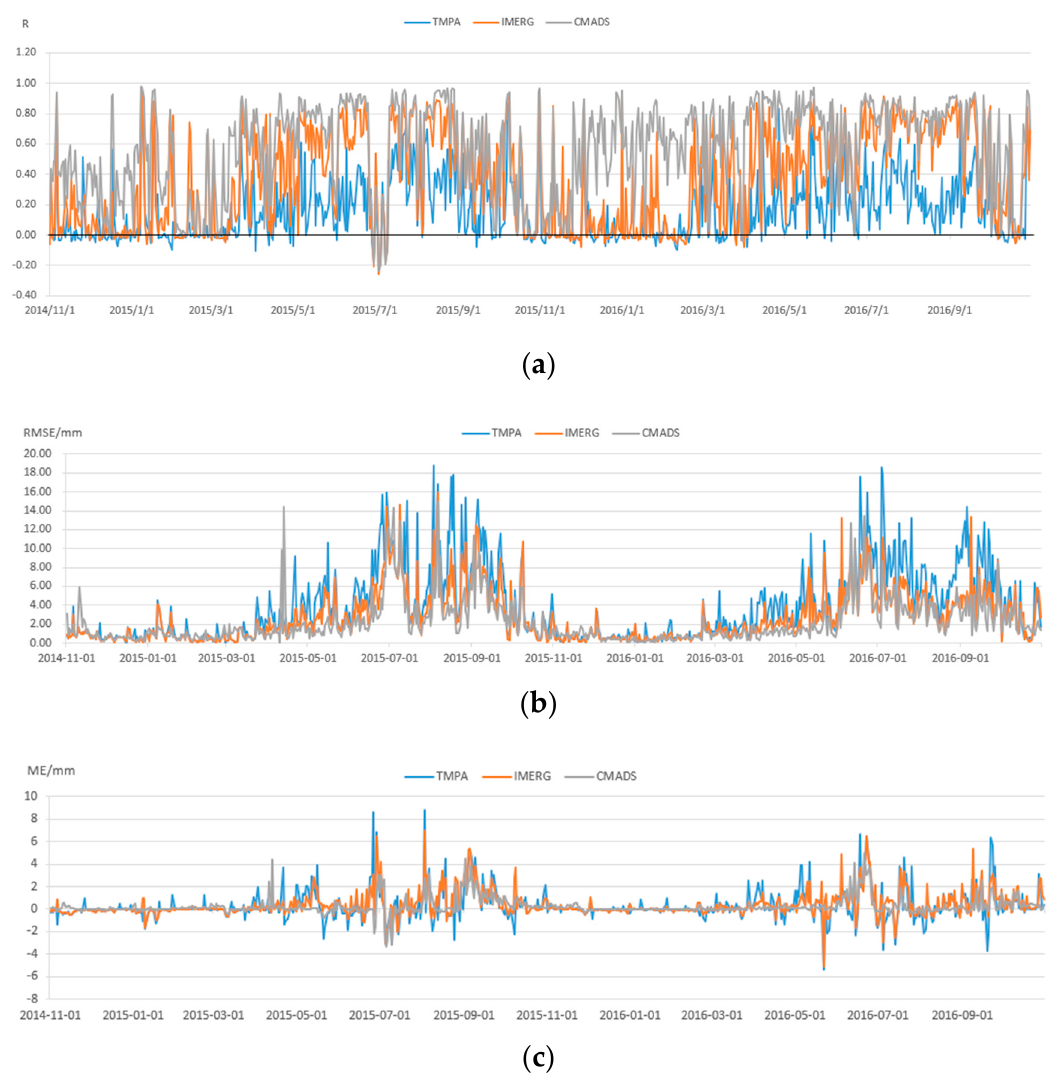
Figure 7. Time series graph of error markers: ( a ) R; ( b ) RMSE; ( c ) ME.